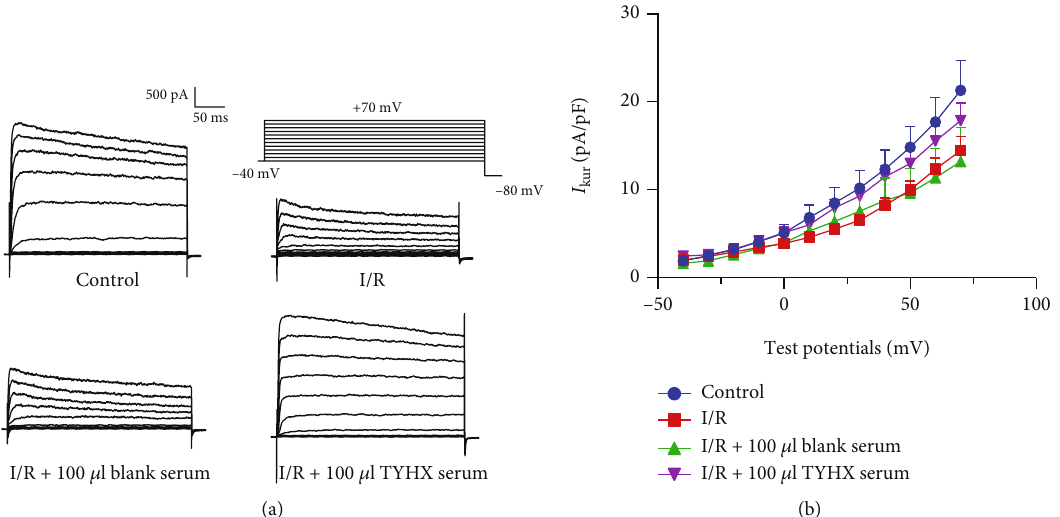
Figure 6: I-V curves of the I